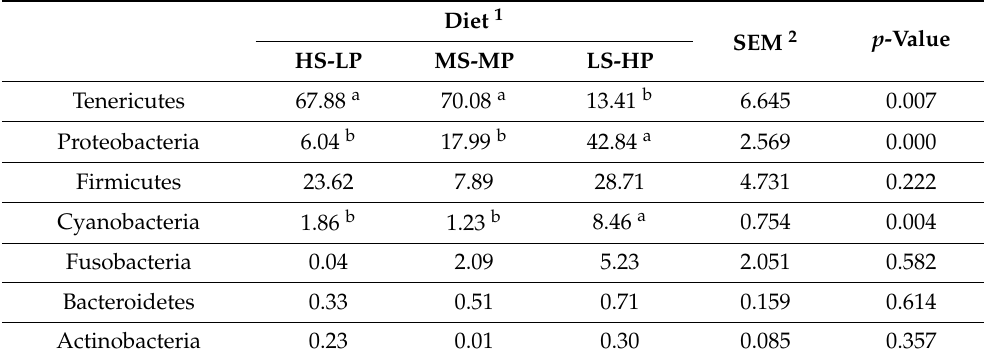
Table 8. Effect of diets on the abundance (%) of the most frequent phyla in the microbiota of Tenebrio molitor